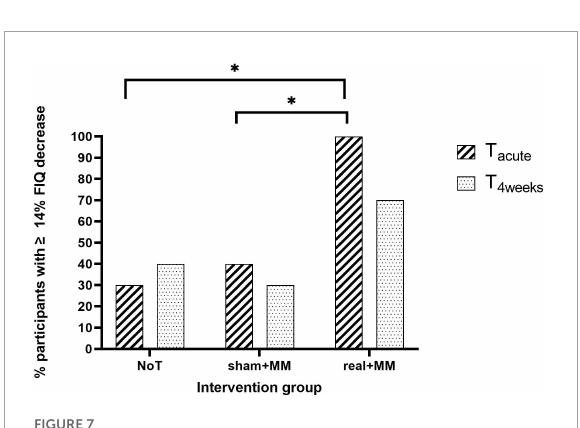
FIGURE7 Clinically meaningful quality of life improvement. Bar chart illustrating the percentage of participants who reported ≥ 14% reduction in FIQ scores at T acute and T 4weeks compared to baseline in the NoT, sham + MM and active + MM groups. ∗ p <